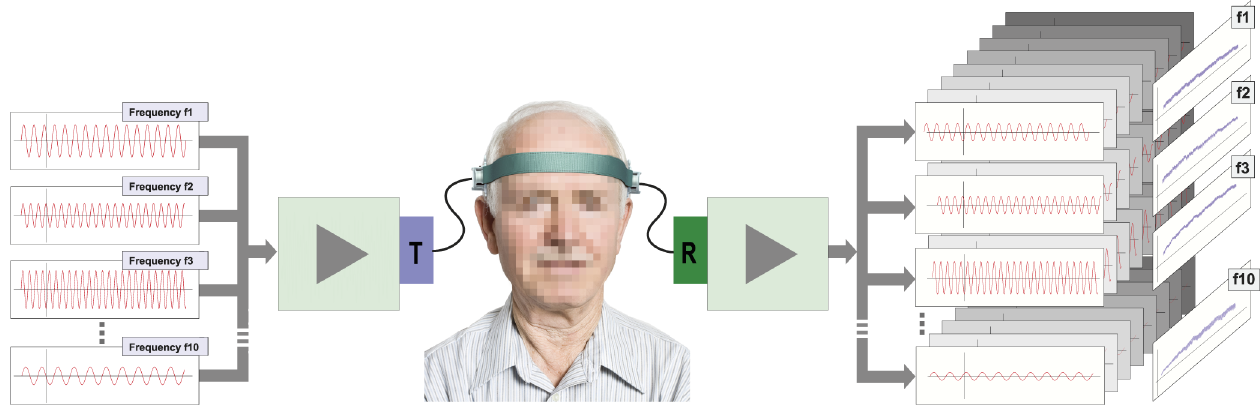
Fig 1. An outline of the process of forming a multidimensional phase bundle: The compound multispectral signal is being emitted at one side of a patient’s head, and after transversing skull bones and the brain tissue, it is being received on the other side. Then, the received signal is being decomposed into sine waves with base frequencies equal to the ones included in the original signal, and their phases φ1, ... , φH (here H = 10) are reconstructed.